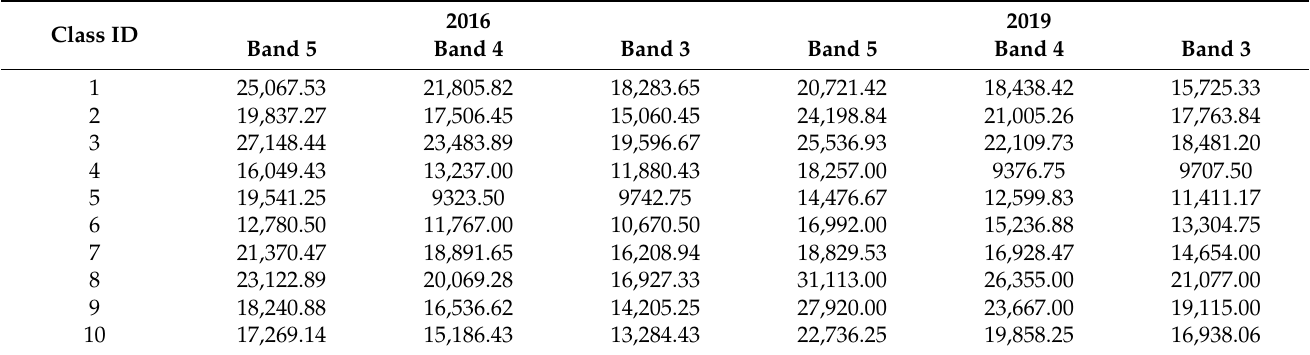
Table 4. Pairwise comparison of the k-means classification for Bands 5-4-3 of the Landsat-8 OLI/TIRS images for 2016 and 2019 in Qena Bend region 1 .